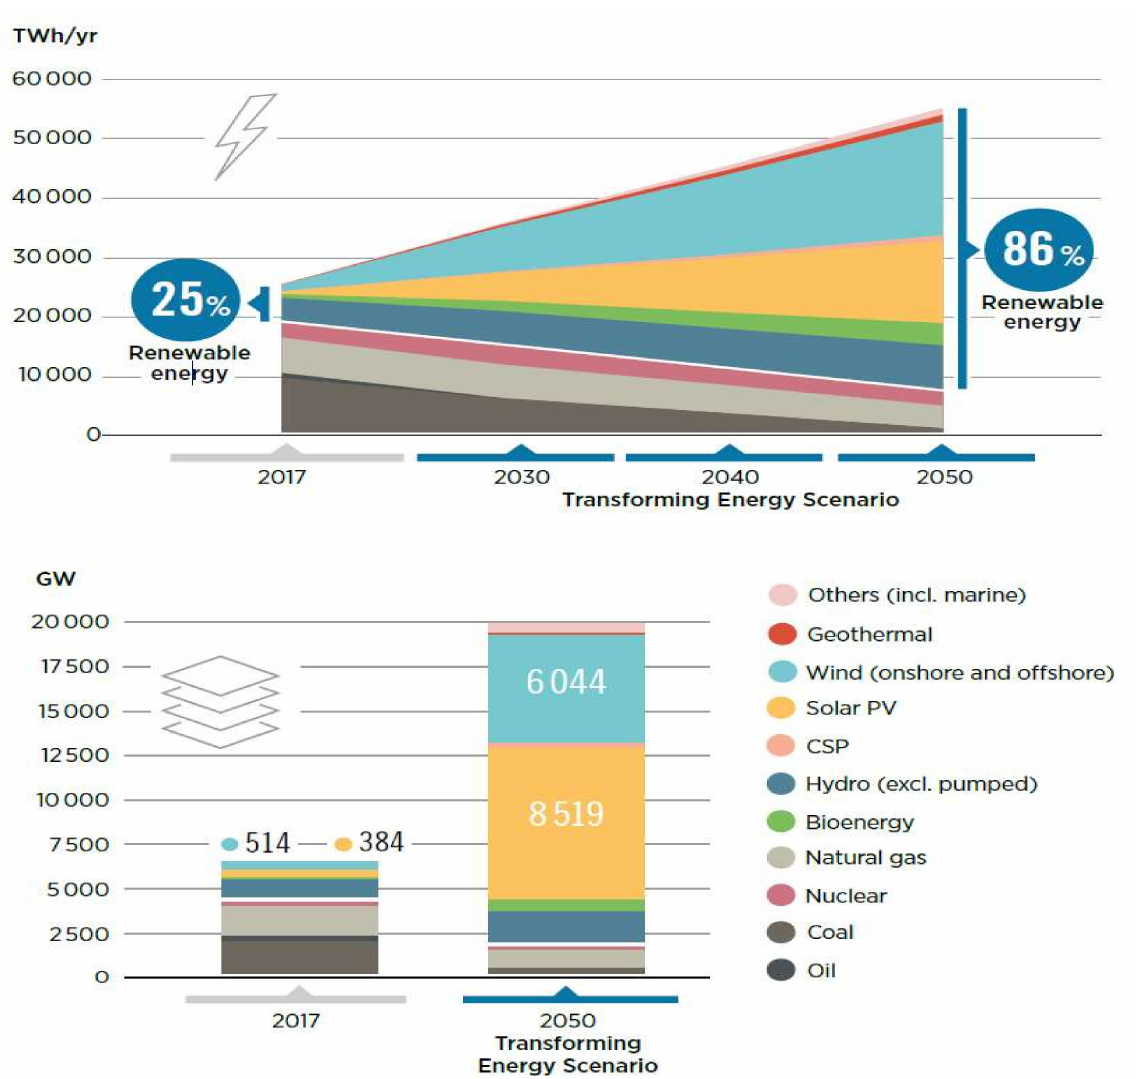
Figure 3. Electricity generation ( top ) and installed capacity ( bottom ) of different energy sources from 2017 to 2050